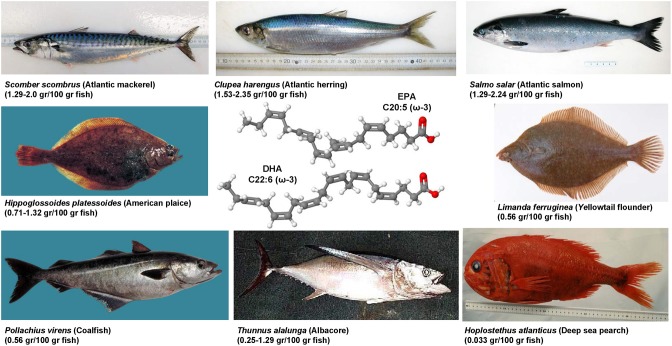
Fish as a dietary source of ω-3 fatty acids. Cold-water fishes such as salmon, herring, mackerel, and others are dietary sources of ω-3 fatty acids. They are characterized by a double bond at the third carbon atom from the end of the carbon chain. The depicted fishes contain high concentrations of eicosapentaenoic acid (EPA, CAS 10417-94-4) and docosahexyenoic acid (DHA, CAS 6217-54-5). The grams of ω-3 fatty acids per 100 gr fish is given in parentheses. The different fish images were published with the kind permission of Mr. Claude Nozères, Government of Canada, Department of Fisheries and Oceans (www.marinespecies.org/carms/photogallery.php).